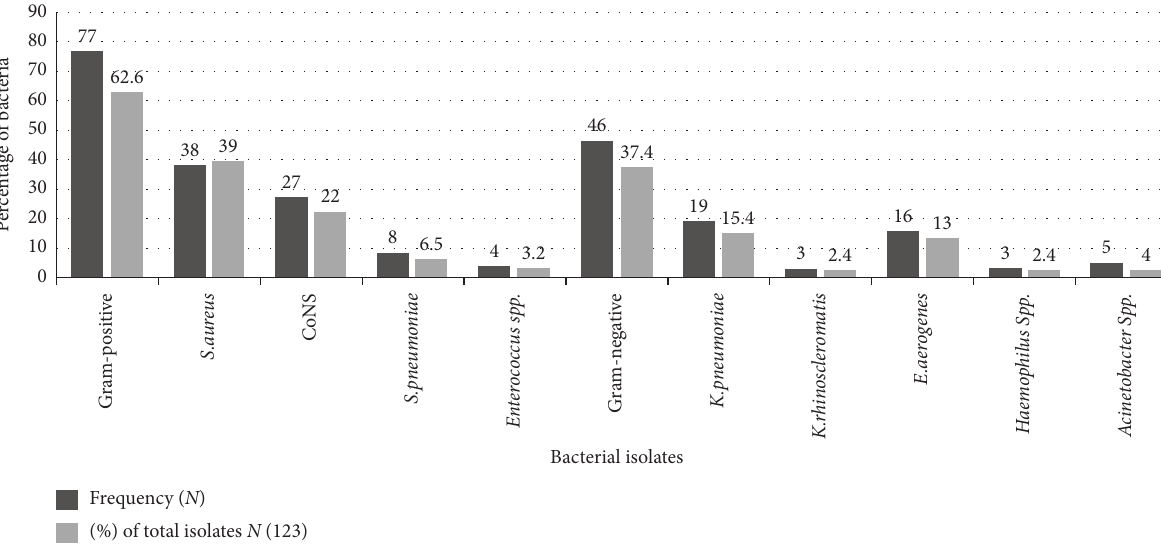
Figure 1: Distribution of bacterial isolates among blood culture-positive HIV/AIDS patient at Felege Hiwot Referral Hospital.